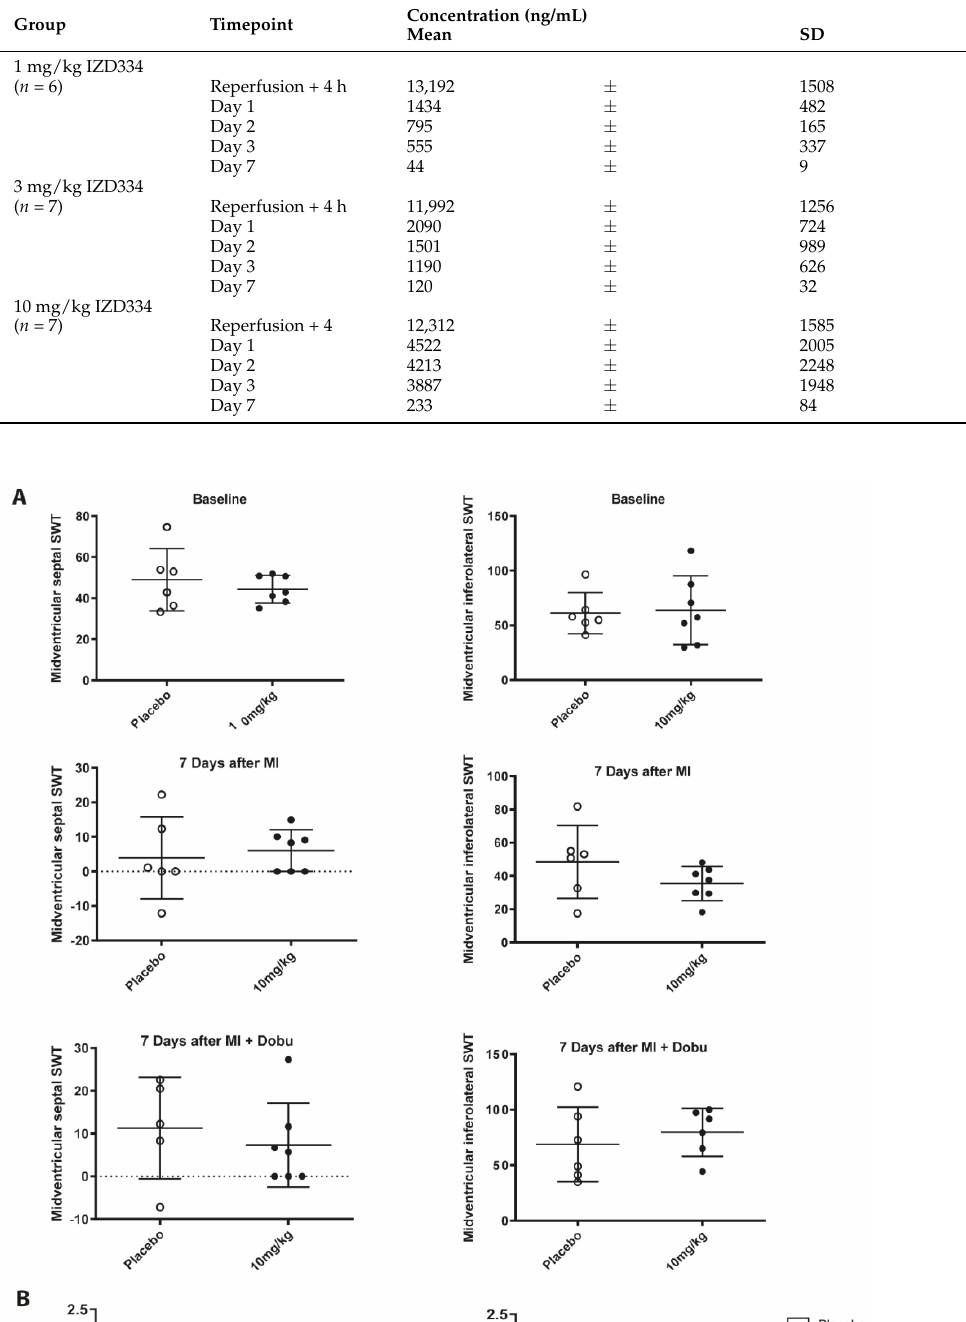
Figure A2. Histological analysis of infarct tissue ( n = 6 – 7). ( A ) Collagen formation. ( B ) Immune cell infiltration.